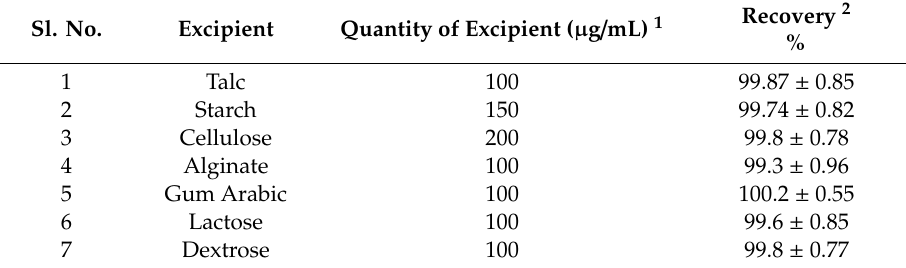
Table 3. E ff ect of common excipients—recovery study.